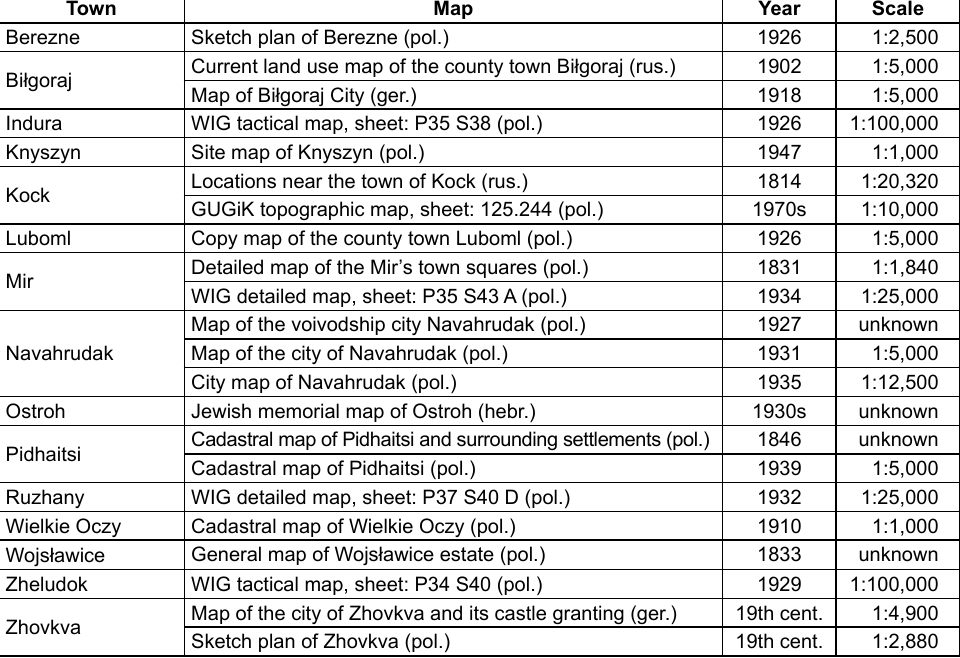
Tab. 3. List of archival maps and plans used for 3D modelling Town Map Berezne